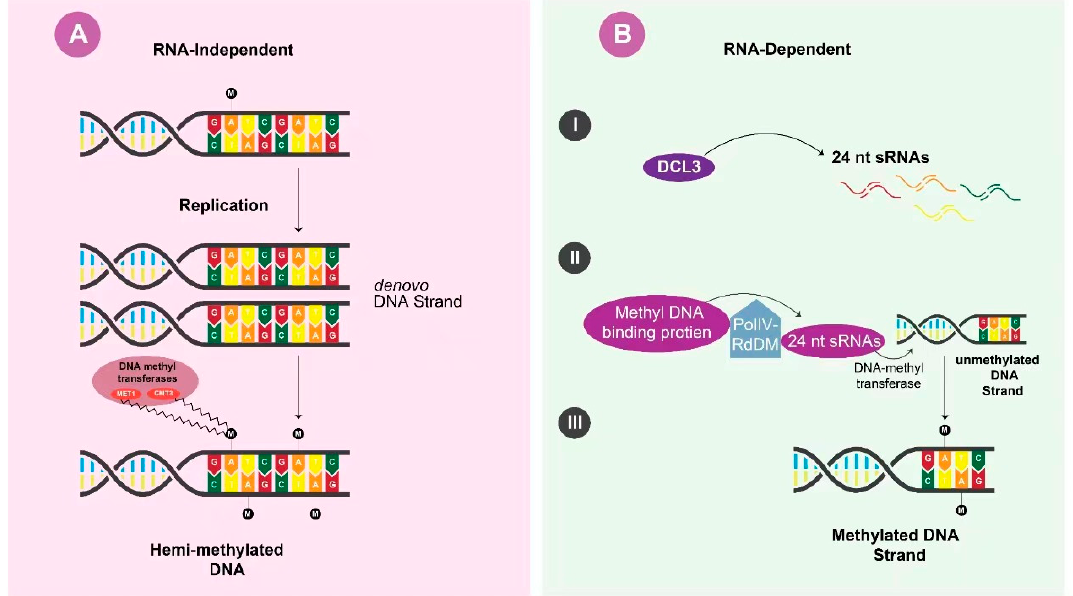
Figure 3. Maintenance of epigenetic silencing. ( A ) RNA-independent maintenance depends on the DNA methyltransferases MET1 and CMT3 recognizing hemimethylated Cs in the symmetrical context of de novo DNA strands for maintenance of epigenetic marks. ( B ) DCL3 synthesized 24nt sRNAs are recruited by PolIV-RdDM and loaded on the primary genomic location of RdDM by methyl DNA-binding proteins, and then DNA methyltransferase methylates the unmethylated strand to create gene silencing. PolIV-RdDM (Polymerase IV- RNA-directed DNA methylation).